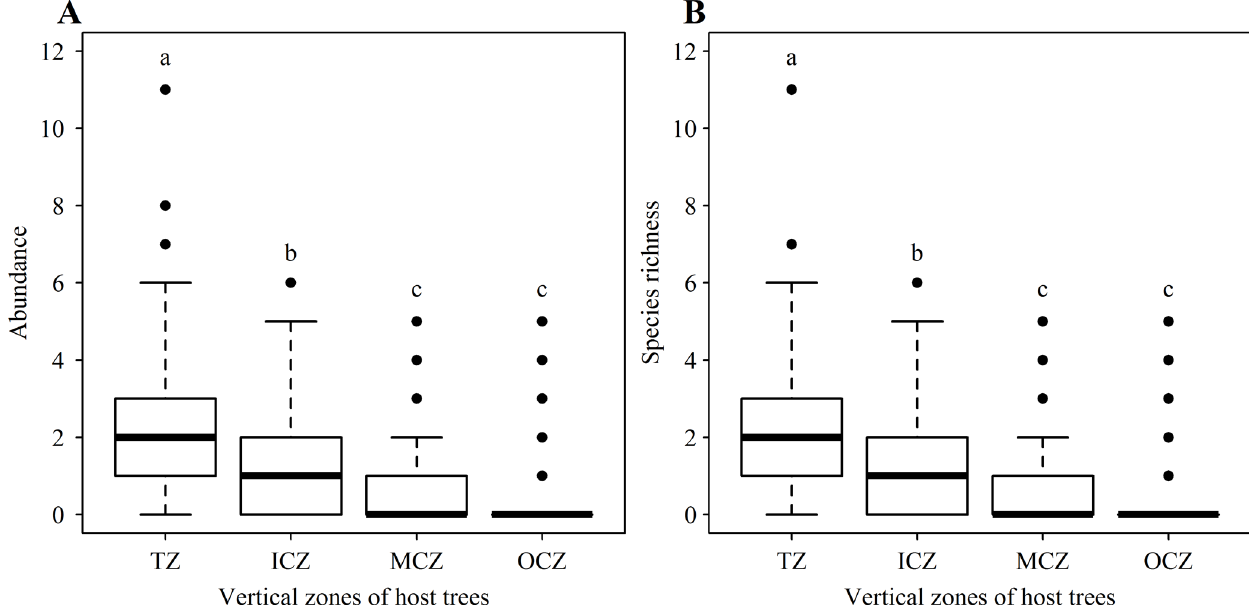
Fig 2. Abundance (A) and species richness (B) of vascular epiphyte at the different crown zones upon host trees. Different letters above boxes indicated significant difference for alpha = 0.05. TZ, ICZ, MCZ and OCZ indicated trunk zones, inner crown zones, middle crown zones and outer crown zones of host trees,